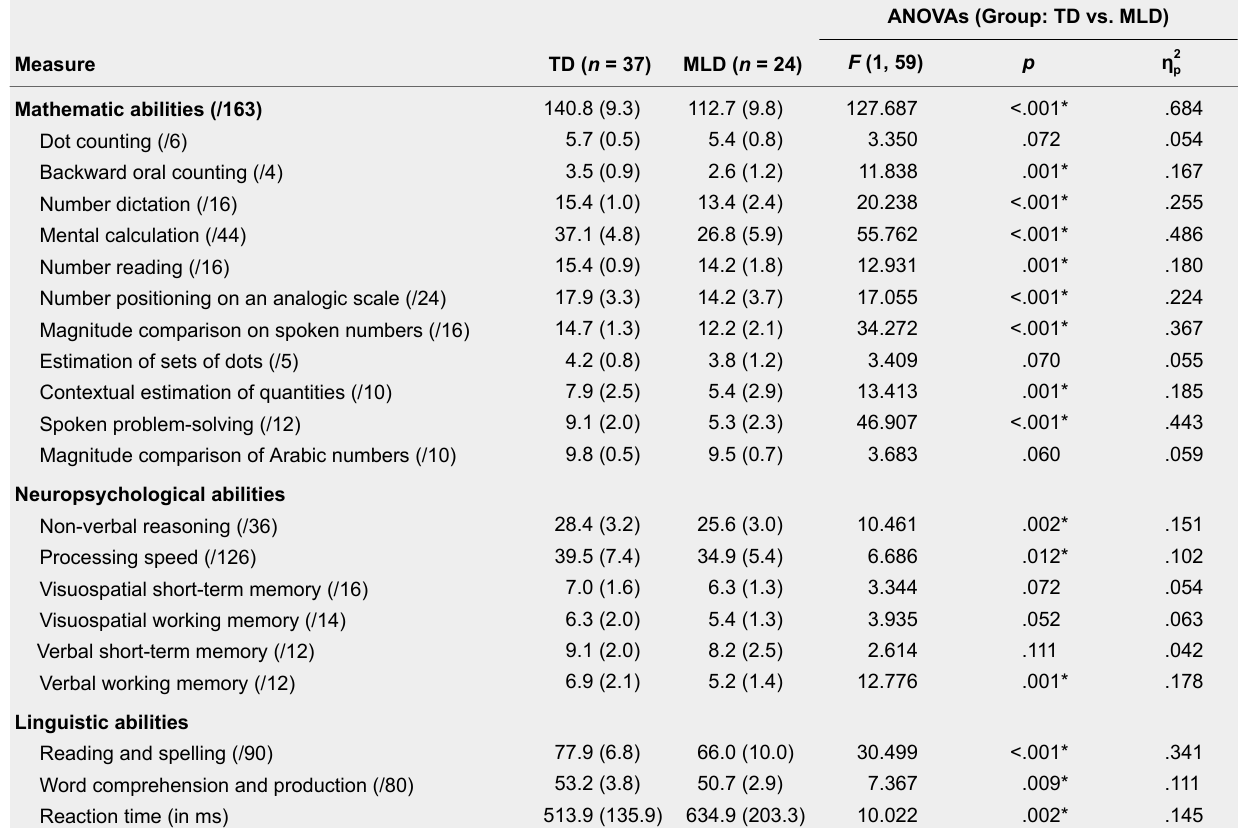
Participants’ General Cognitive Abilities: TD and MLD (mean (SD) and statistics)